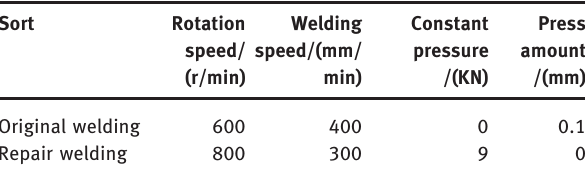
Table 2: Technological parameters of welding for original joints with tunnel defect and repaired joints.